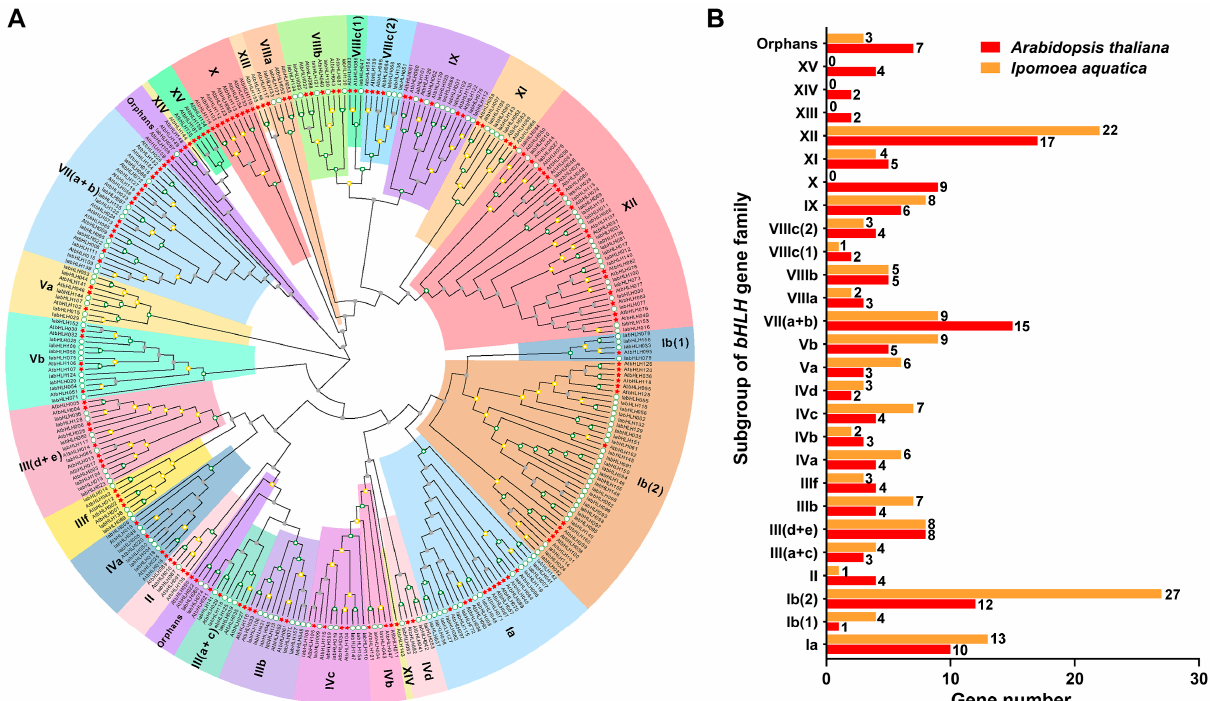
Figure 3. Phylogenetic relationships of IabHLHs and AtbHLHs ( A ) The phylogenetic tree contains 157 IabHLH proteins and 148 AtbHLH proteins. The hollow green circles represent IabHLHs, while the solid red pentagons represent AtbHLHs. The gray, yellow, and green squares represent the bootstrap values varied from 0 to 49, 50 to 79, and 80 to 100, respectively. ( B ) The number of IabHLHs and AtbHLHs in each subfamily. Int. J. Mol. Sci. 2023 , 24 , x FOR PEER REVIEW